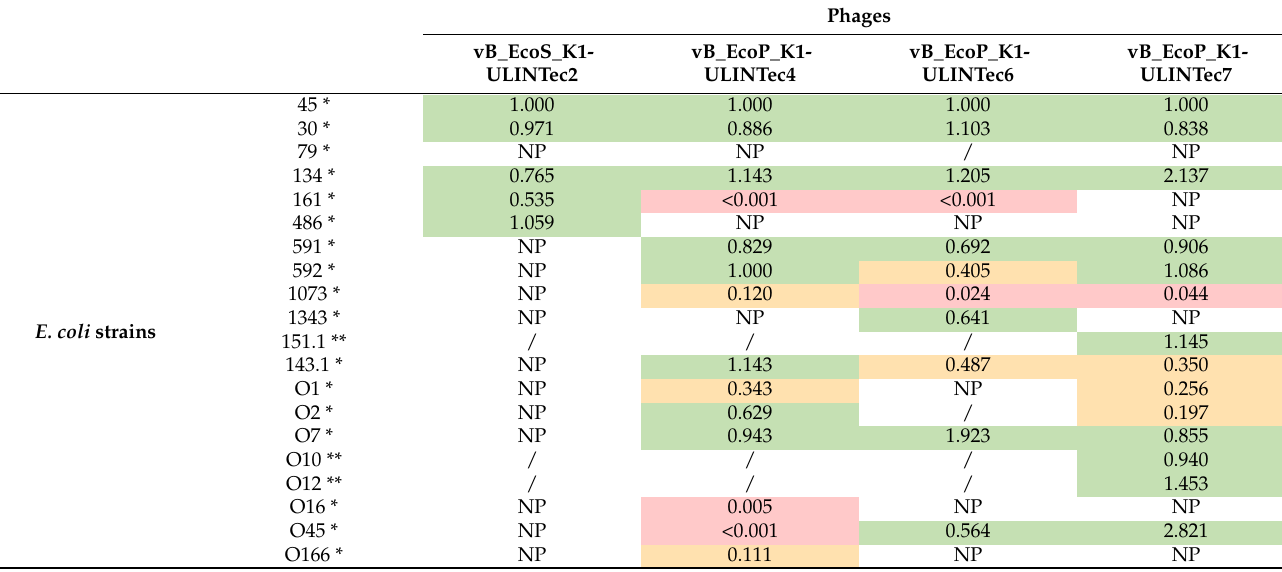
Table 2. Efficiency of plating (EoP) values for phages vB_EcoS_K1-ULINTec2, vB_EcoP_K1-ULINTec4, vB_EcoP_K1- ULINTec6, and